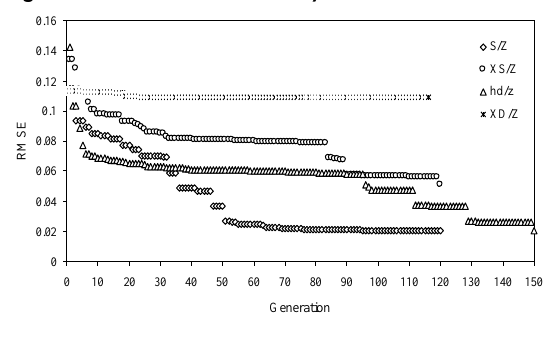
Figure 19. Root mean square error versus generation in